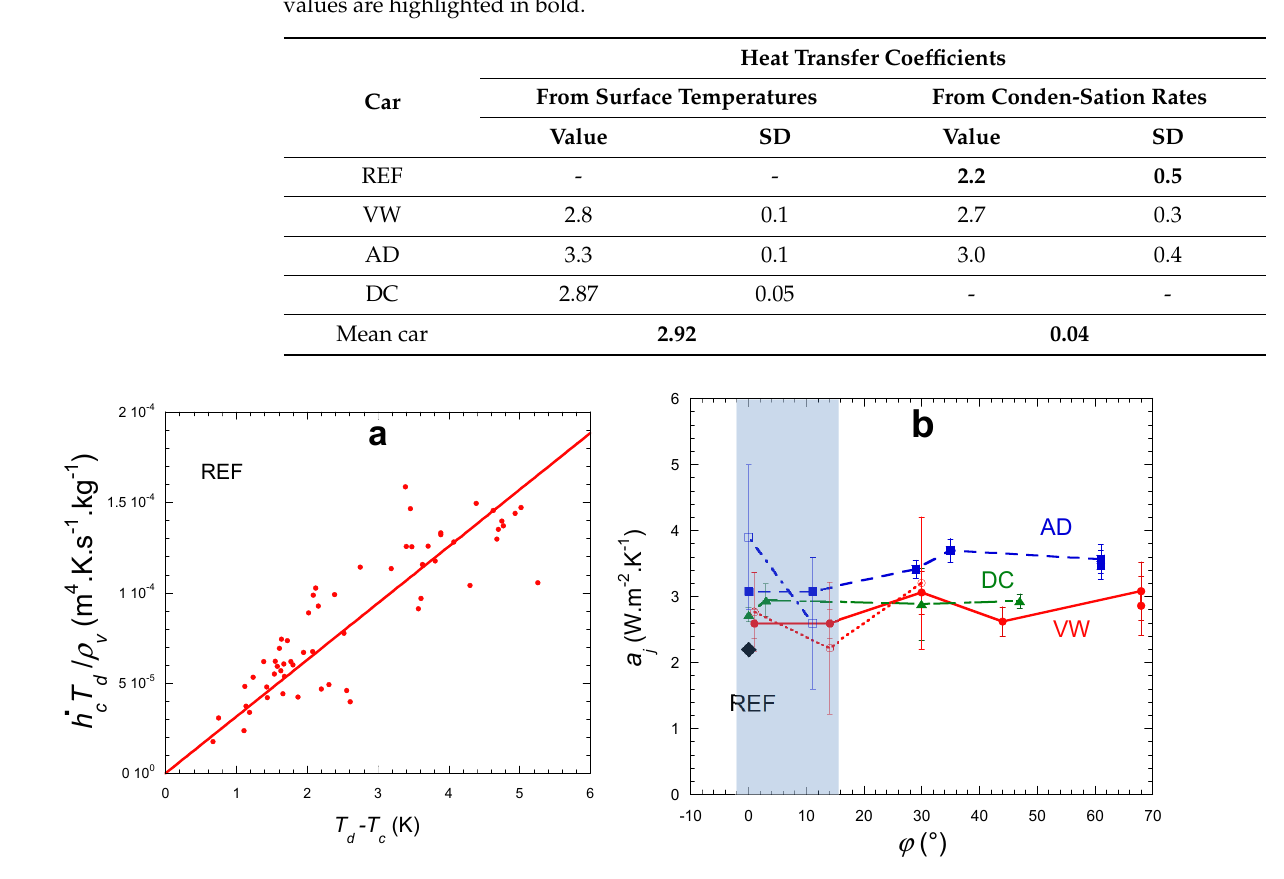
Figure 16. ( a ) Variation of h c T d / ρ v with respect to T d − T c for the Ajaccio reference surface. The proportionality factor is (3.14 ± 0.09) × 10 − 5 m 4 .K.s − 1 .kg − 1 (uncertainty: one standard deviation) corresponding to the value a REF = 2.2 W.m − 2 .K − 1 . ( b ) Calculated heat transfer coefficient at different angles as calculated from (full symbols) the a j / a REF values from temperature measurements (Section 4.2.1, Table 5) with a REF = 2.2 W.m − 2 .K − 1 , and the means of ℎ(cid:4662) (cid:3030) /(𝑇 (cid:3031) − 𝑇 (cid:3030) ) data from Equation (38) (values from Table 6, open symbols). VW car: red circles, full and dotted lines. AD car: squares, interrupted, and double interrupted lines. DC car: Green triangles and large interrupted line. REF: Black diamond. The shadow area corresponds to thermally isolated surfaces. Table 6. Mean values of heat transfer coefficients from surface temperature using the value a REF (bold) = 2.2 W.m − 2 .K − 1 in Table 5, and from condensation rates using Equation (38). The mean values are highlighted in bold.